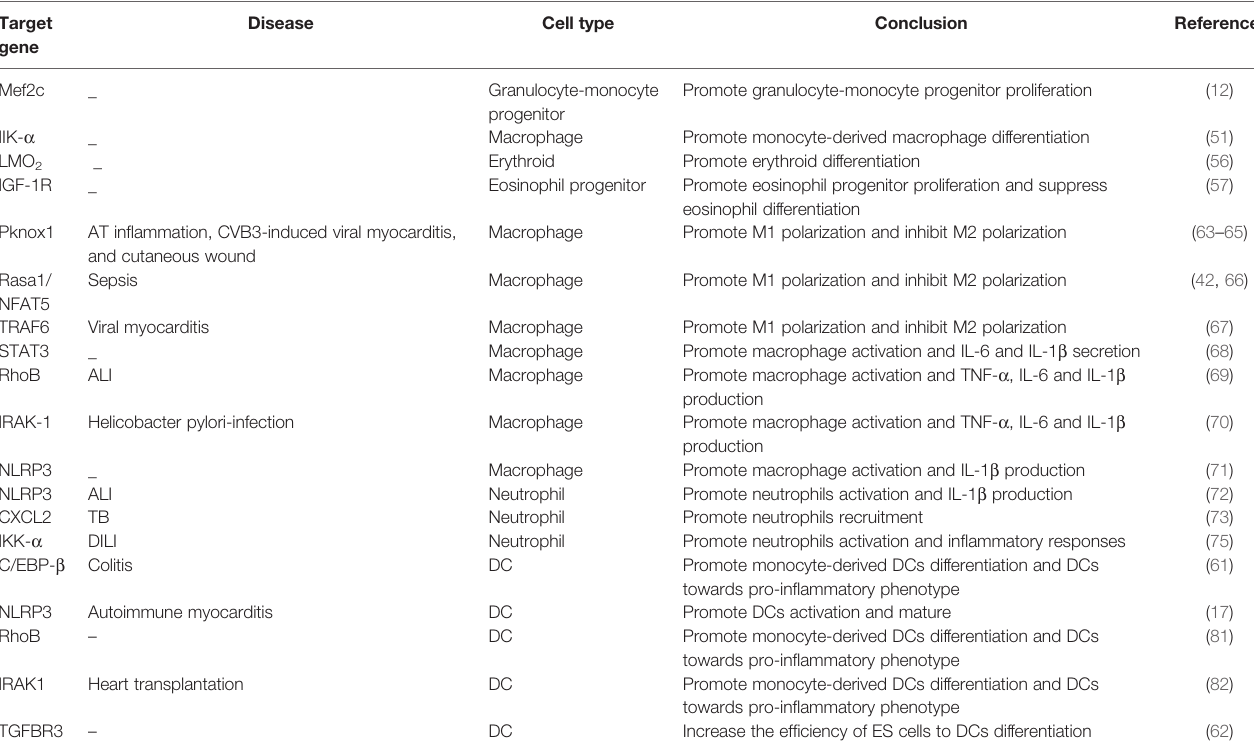
TABLE 1 | Targets for miR-223 in the immune system. Target gene